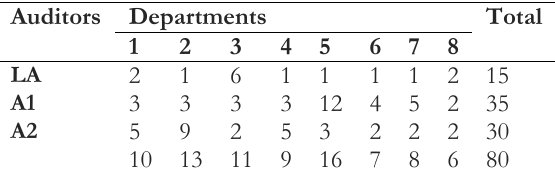
Table 2. Allocation of safety auditors to departments.